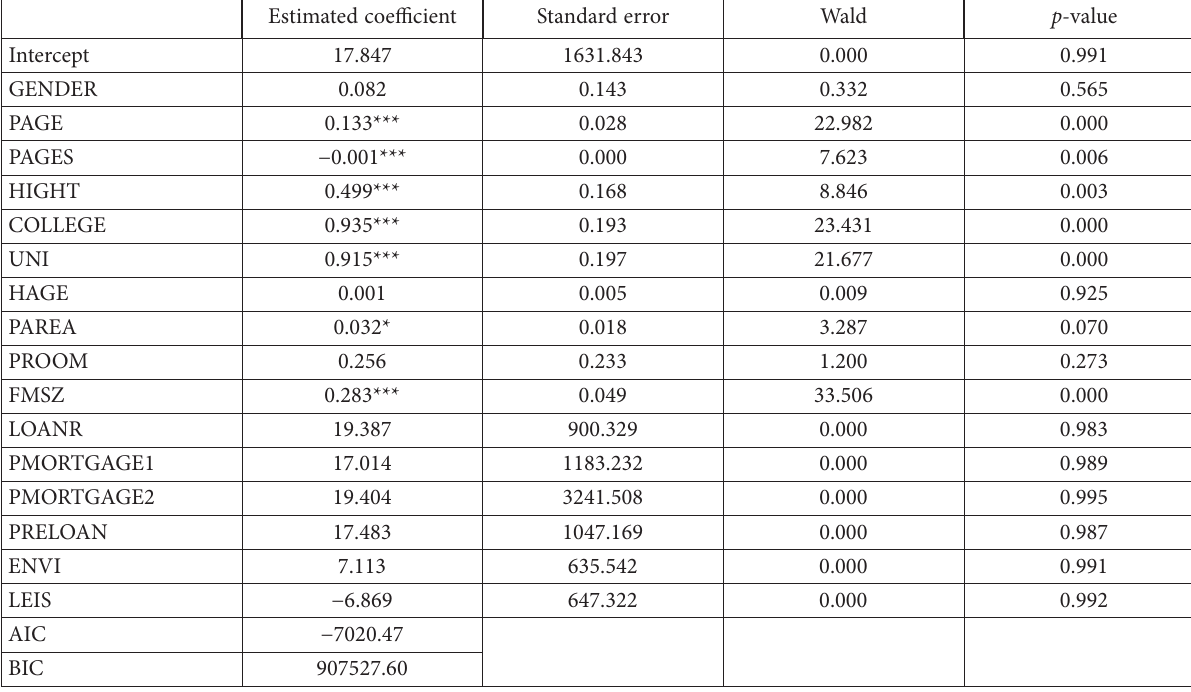
Table A2. Coefficient estimates with binary logistic regression model Estimated coefficient